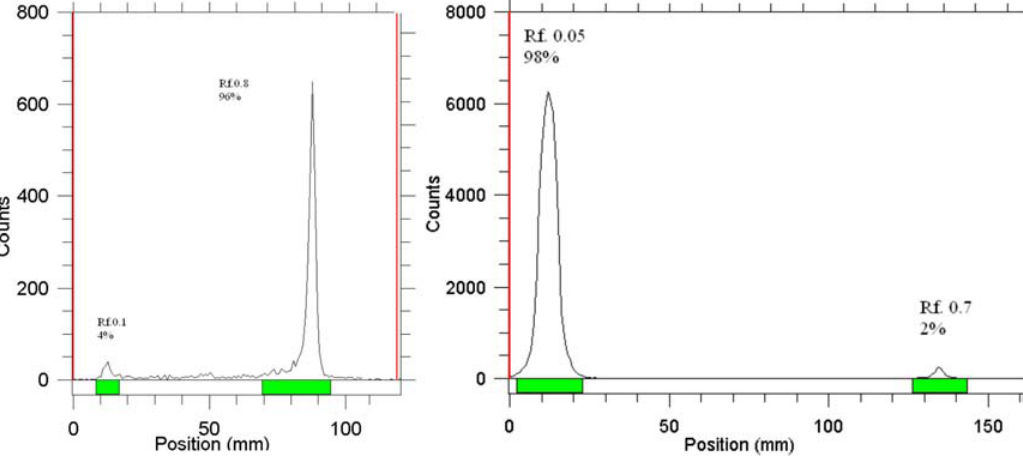
solution in DTPA solution (pH. 4) (left) and 10% ammonium acetate:methanol (1:1) 3